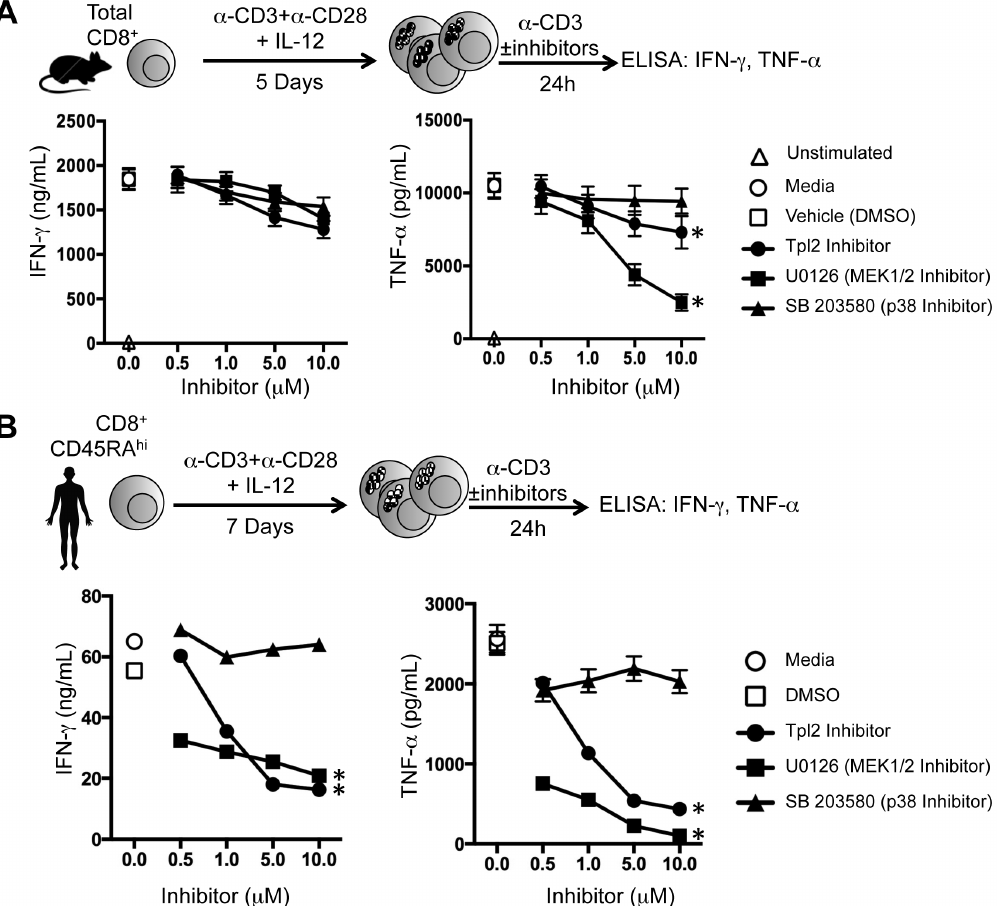
Figure 5. Pharmacological inhibition of Tpl2 blocks effector cytokine secretion from human but not murine CTLs invitro . (A) Total CD8 + T cells were isolated from WT C57BL/6 splenocytes and stimulated with plate-bound anti-CD3 + anti-CD28 in the presence of rhIL-2 and rmIL-12. On day 3 post stimulation, the cells were split 1:10 in cIMDM + 50 U/mL rhIL-2. On day 5 post stimulation, cells were harvested, counted, and re- stimulated for 24 h with plate-bound anti-CD3 + 50 U/mL rhIL-2 in the presence or absence of the indicated inhibitor conditions to test for effector cytokines secretion. IFN- c (left panel) and TNF- a (right panel) in the supernatant were measured using ELISA. Mean 6 SEM is plotted and the error represents five individual mice, n=5. (B) Naı¨ve CD8 + (CD8 + CD45RA + ) T cells were isolated by negative selection or FACS from healthy human PBMC and stimulated with plate-bound anti-CD3 + anti-CD28 and rhIL-12. Cells were split 1:10 with 100 U/mL IL-2 on d3 post stimulation. On d7, cells were re-stimulated with plate-bound anti-CD3 + rhIL-2 (200 U/mL) 6 indicated kinase inhibitors. Supernatant was collected 24 h post 2 o stimulation. IFN- c (left panel) and TNF- a (right panel) in the supernatant were measured by ELISA. Data shown are representative of five independent experiments and mean 6 SEM is plotted. *, p # 0.05 compared to control treated